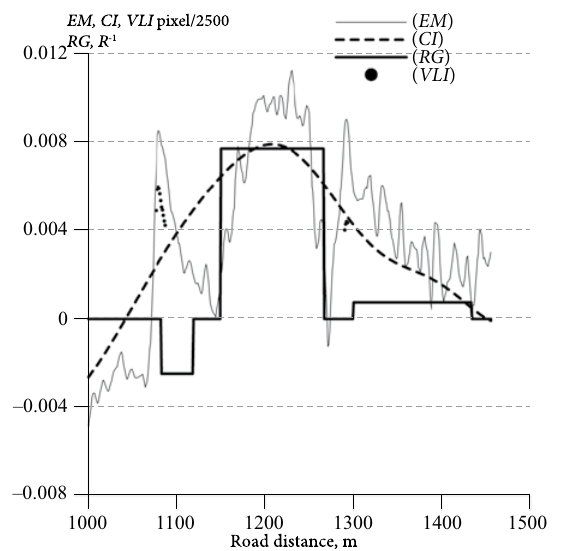
Fig. 8. Relationship between CI function of the sample and EM and VLI for a specific driver (the data concern the road distance from 1000 to 1500